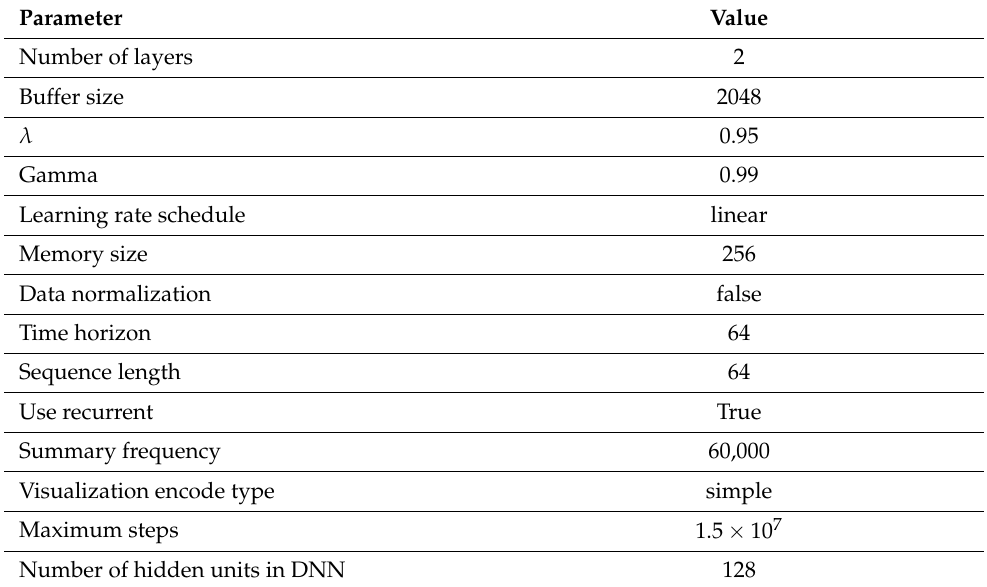
Table 1. Parameters used in the simulation and their